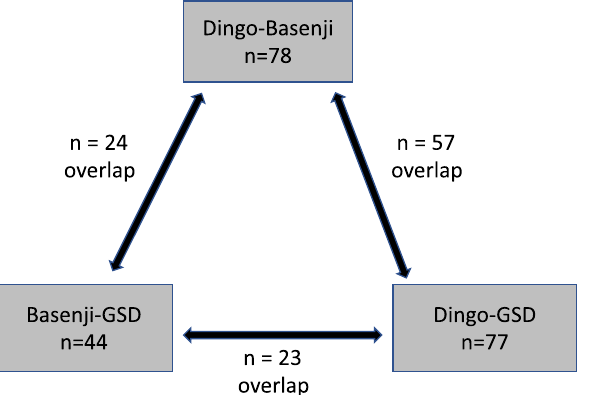
Figure 3. An overview of metabolite differences between the dingo, Basenji and German Shepherd Dog (GSD) detected using pairwise Tukey’s test. Each grey box represents metabolite differences for the respective pair and overlap represents the number of common metabolites detected between each group.